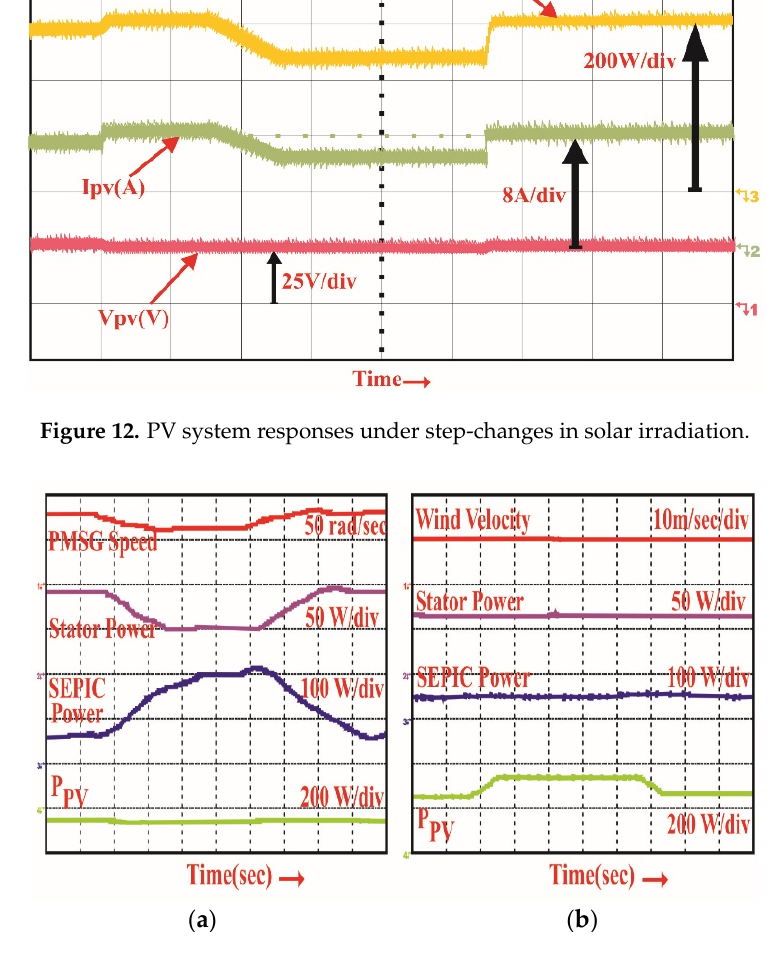
Figure 13. ( a ) Capability of the proposed hybrid micro grid under varying wind velocity and constant solar irradiation; ( b ) Behavior responses of the hybrid micro grid under varying solar irradiance and constant wind velocity.